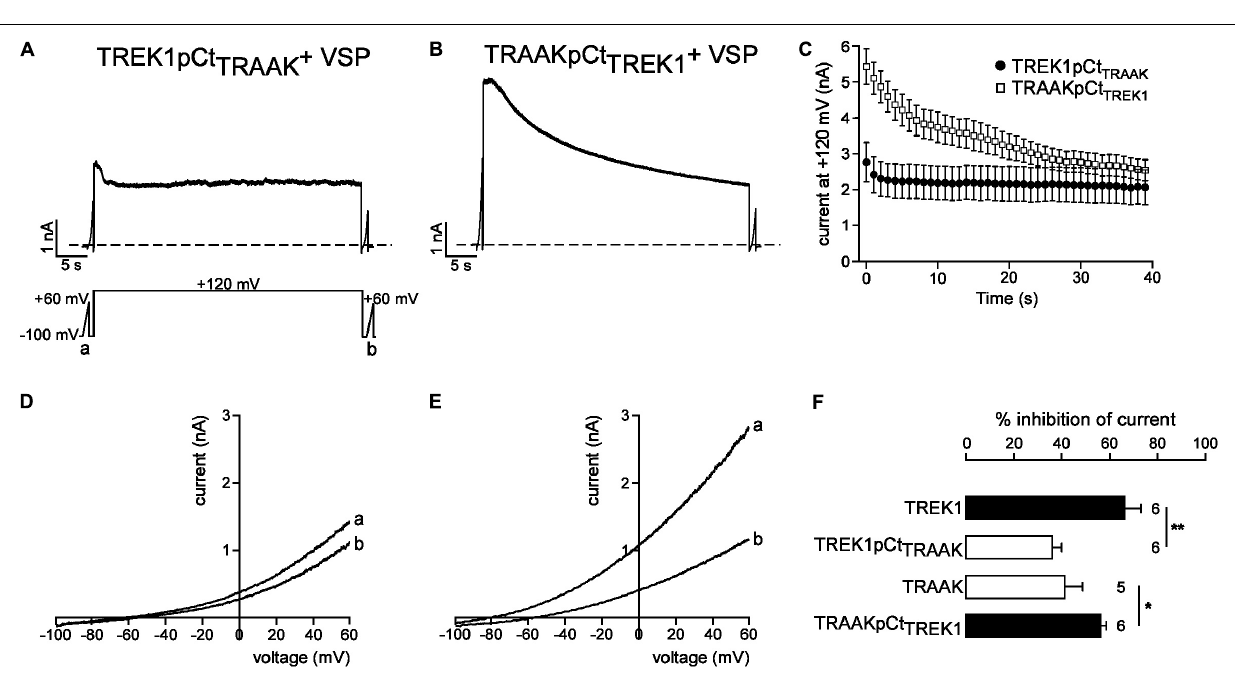
Frontiers in Molecular Neuroscience |